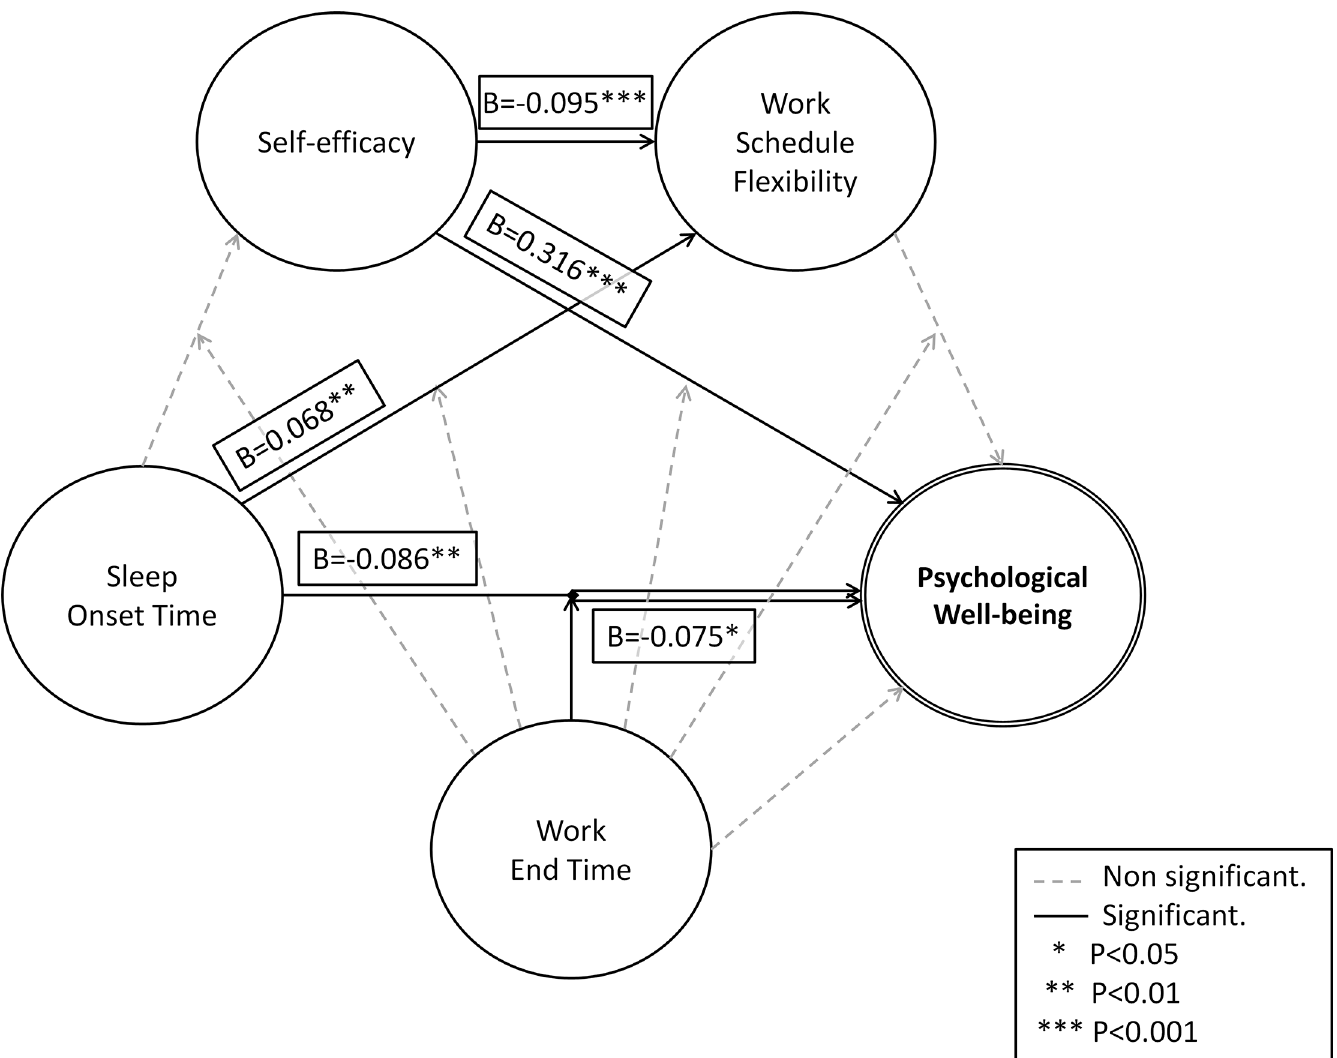
Fig 3. Final statistical